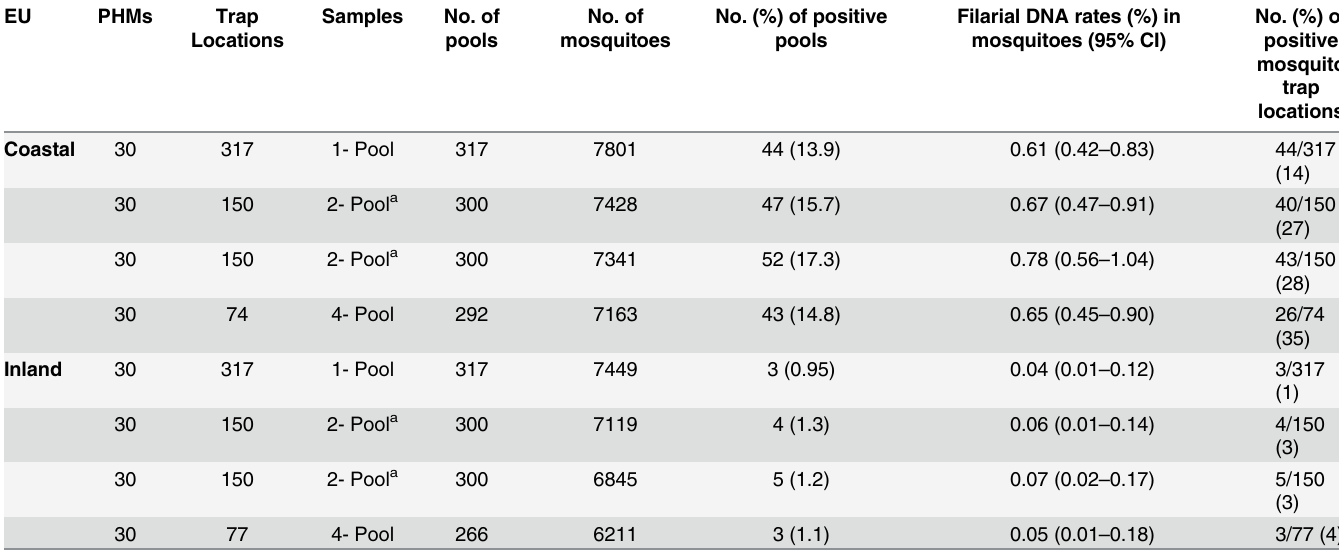
Filarial DNA rates were detected by qPCR. Rates of fi larial DNA in mosquitoes (maximum likelihood and 95% CI) were estimated using PoolScreen 2.03. Filarial DNA rates in mosquitoes were very similar whether 300 pools were sampled at 300, 150, or 75 collection sites. a Two sets of 150 areas with 300 pools each were randomly chosen for